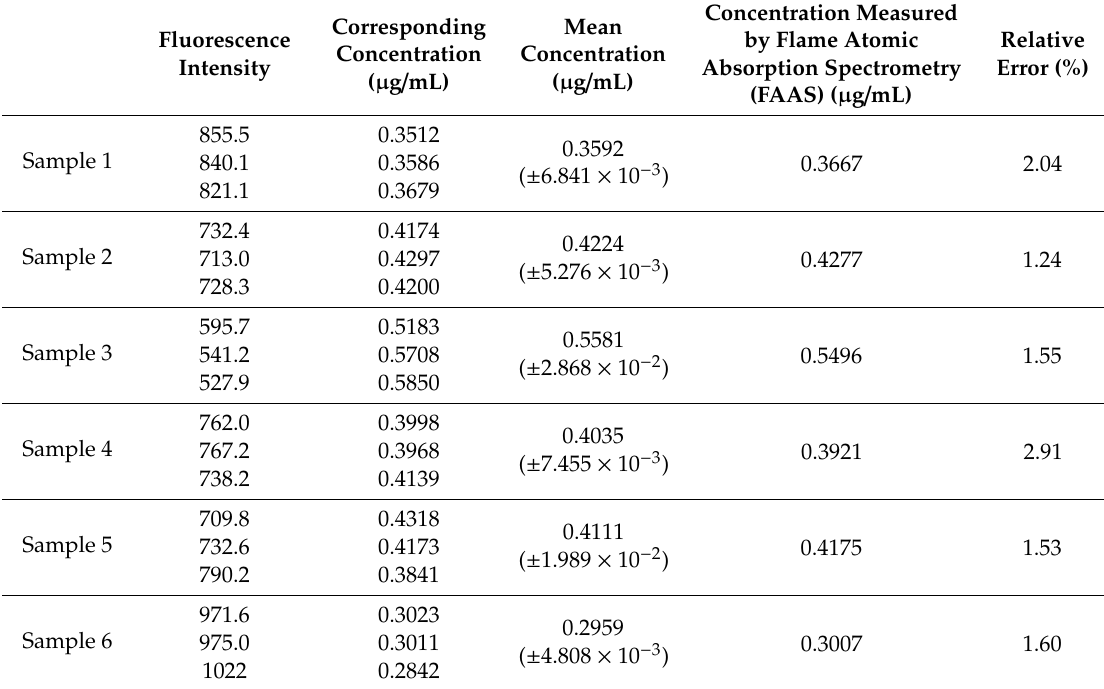
Table 3. The concentrations of copper ion in the oysters.